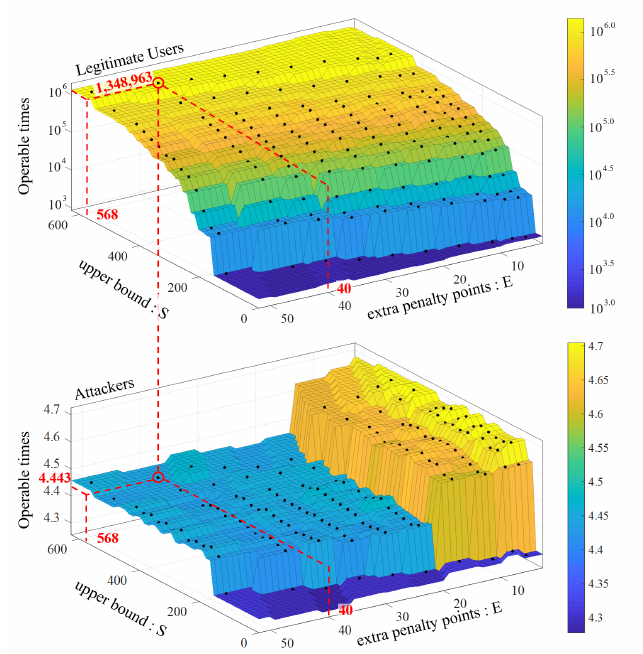
Figure 8. Average operable times of attackers and legitimate users with the change of the upper bound S and extra penalty points E . With a configuration of S = 568 and E = 40, legitimate users can on average operate the device 1,348,963 times before logout, but attackers can only operate the device 4.443 times before being flagged out. In this figure, other parameters remain unchanged as penalty points X = 25 and correction points Y =